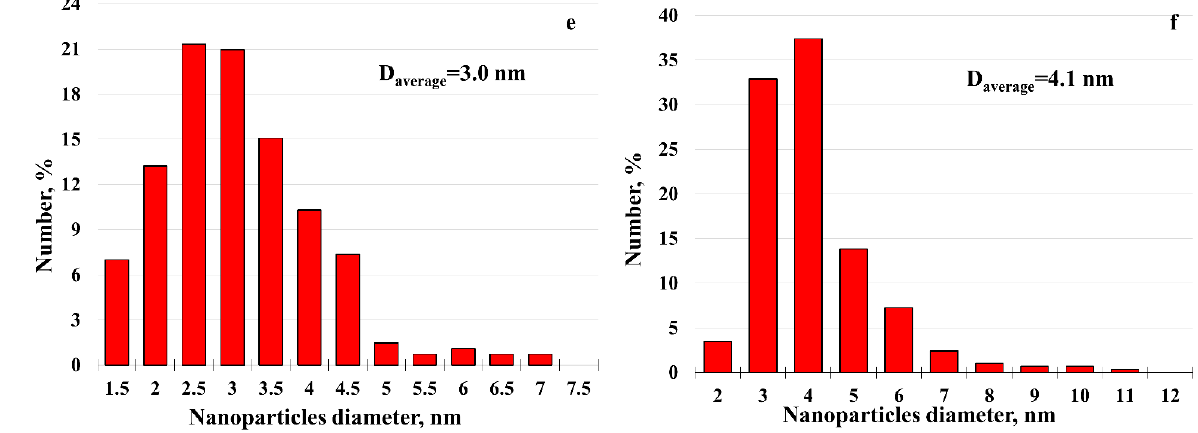
Figure 3. TEM images and histograms of the PtCo nanoparticles size distribution for PCC1 ( a , c , e ) and PCC2 ( b , d , f ).